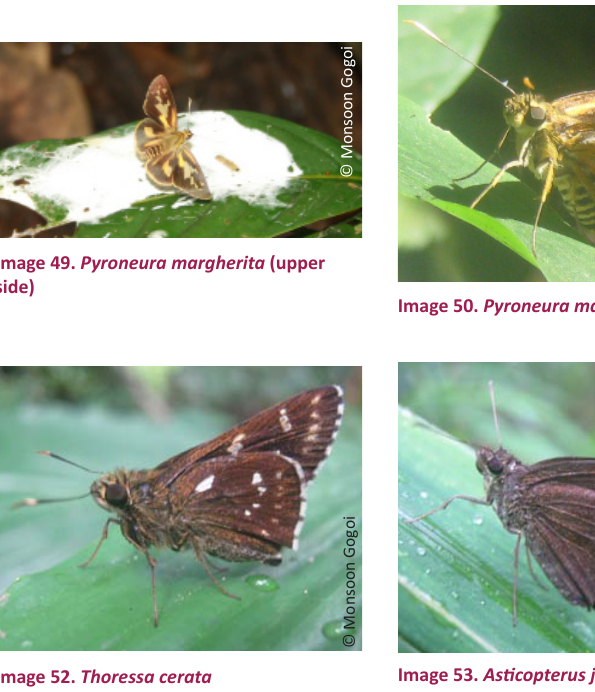
Image 48. Halpe homolea homolea